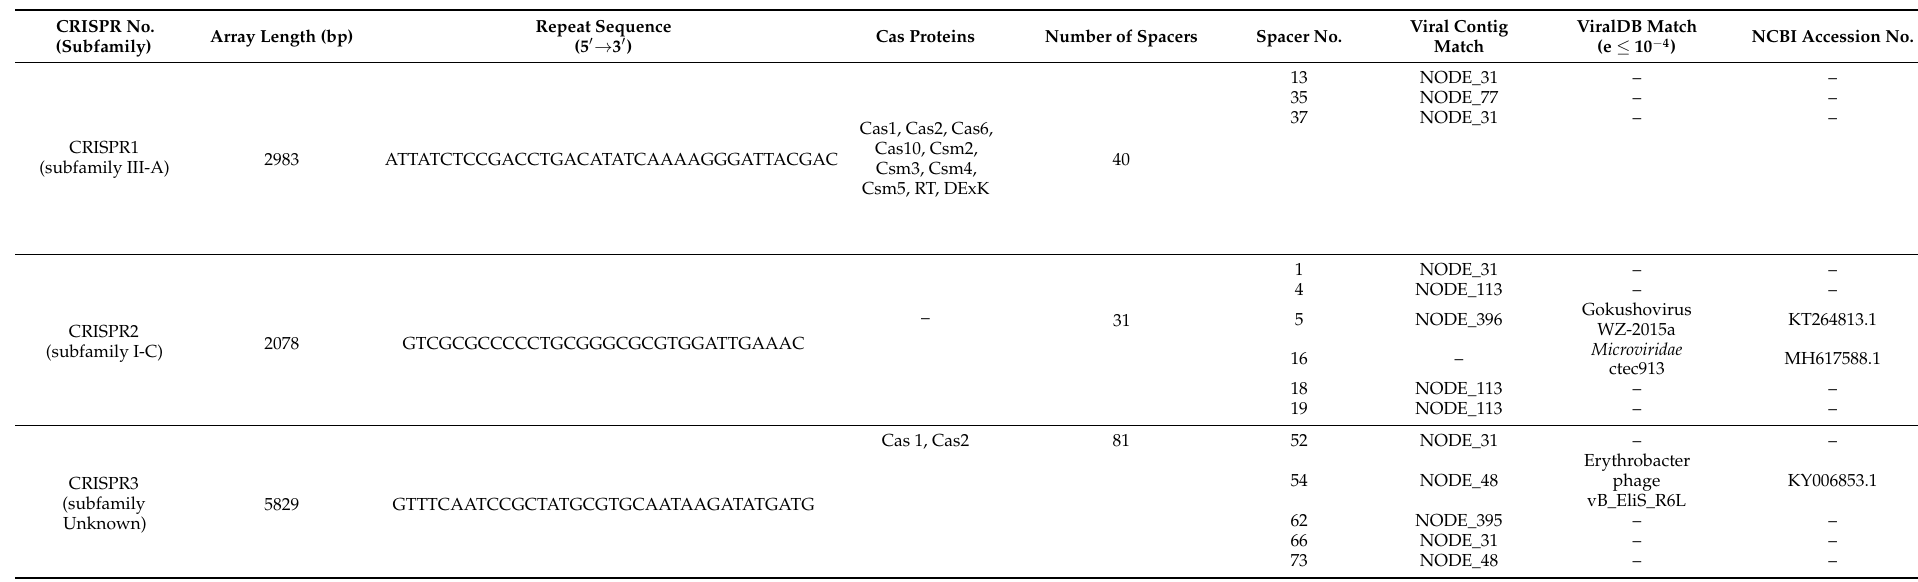
Table 2. Summary of CRISPR arrays identified in the consensus genome of C. clathratiforme and spacer sequence matches C. clathratiforme SAGs-associated viral contigs and viral sequences in publicly available repositories (accessed on March